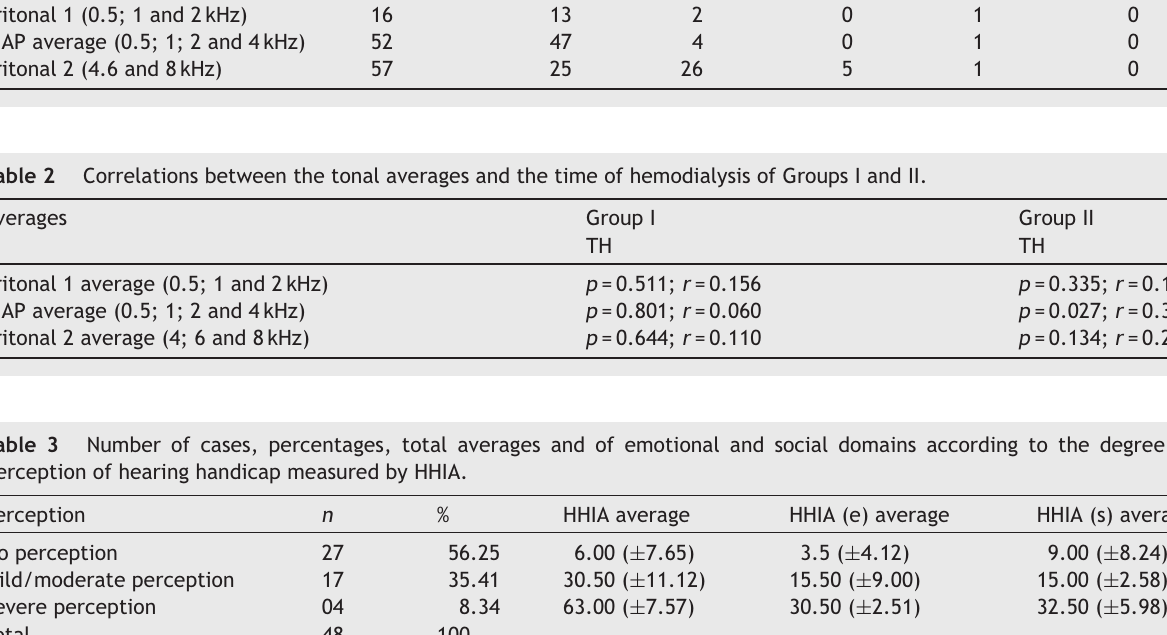
Total of ears with hearing loss and the degree according to Lloyd’s and Kaplan’s and BIAP’s classifications. Tonal averages Ears with Tritonal 1 (0.5; 1 and 2 kHz)